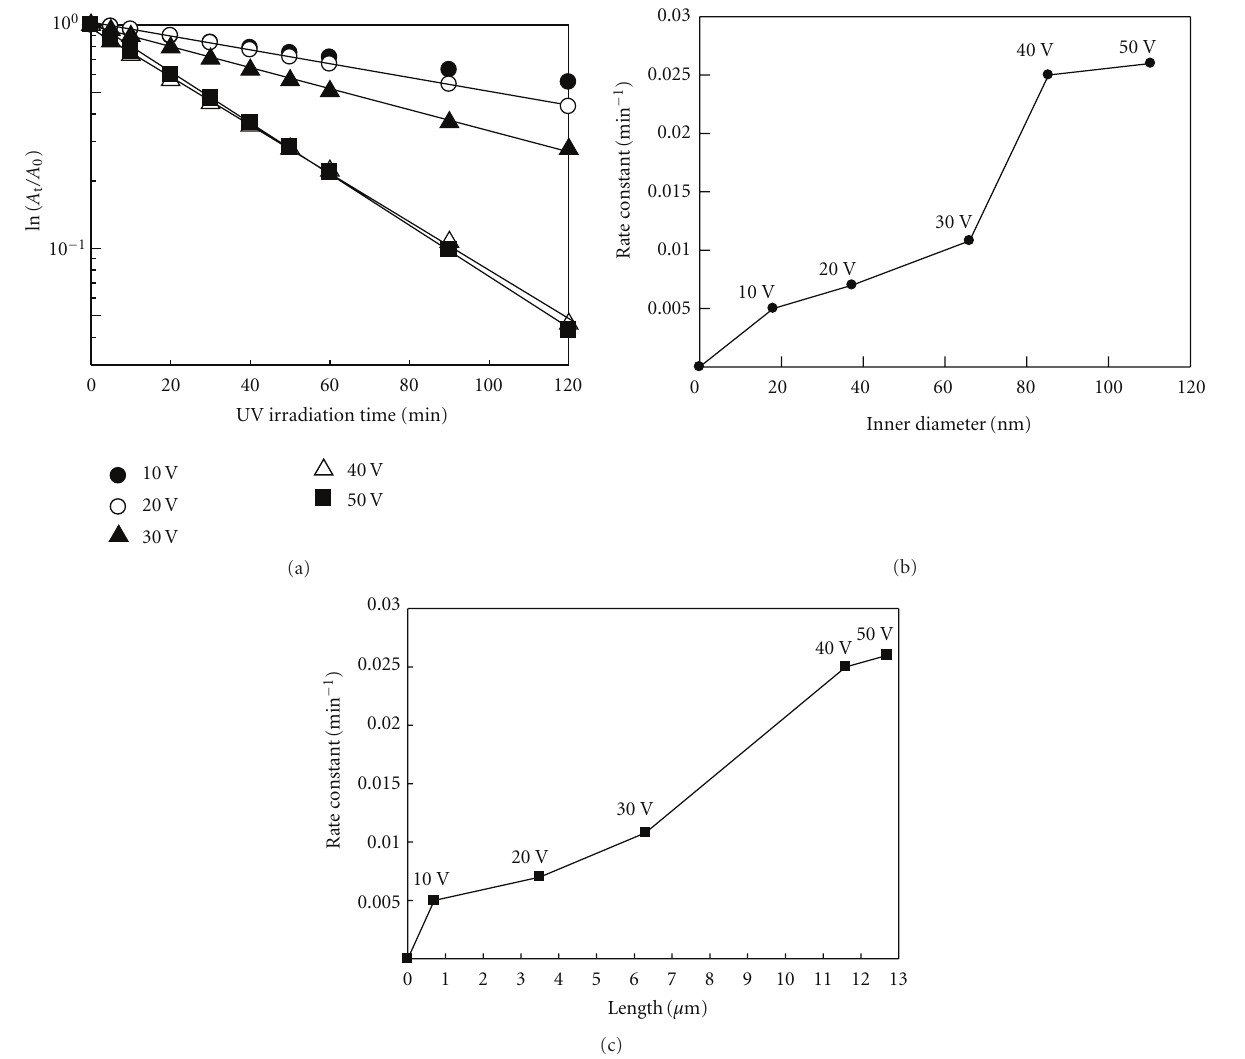
Figure 4: E ff ects of the applied voltage of titania nanotube arrays (TNAs) anodized for 5h (a) on the degree of MB degradation as a ln( A t /A 0 ) (at 365nm) with ultra-violet irradiation time, (b) on the correlation between the inner diameter and the apparent rate constant, that is, the slope of (a), and (c) on the apparent rate constant as a function of the length. The size and electric field factors of TNAs for the apparent rate constant of respective voltage regions are summarized in Table